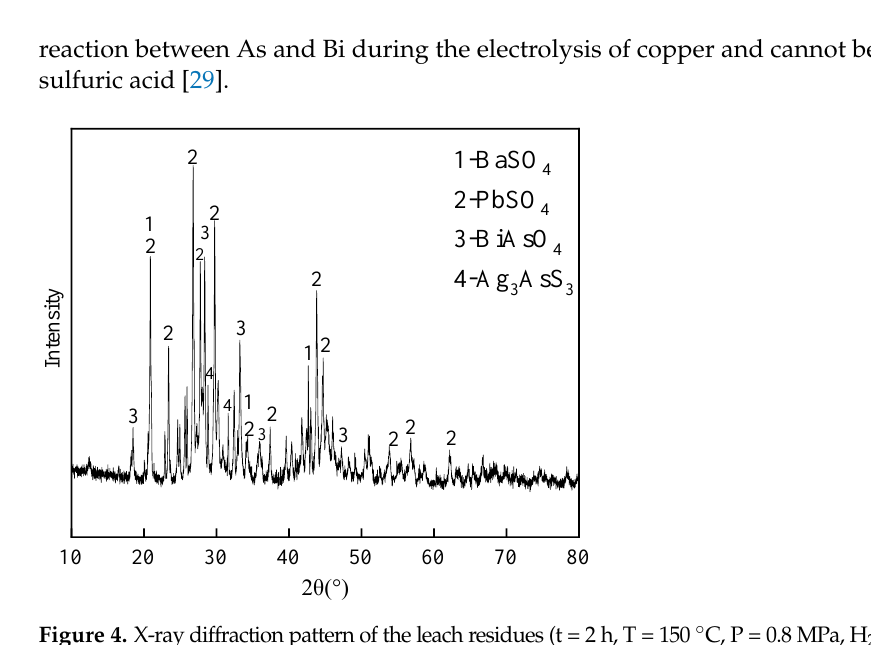
Figure 4. X-ray diffraction pattern of the leach residues (t = 2 h, T = 150 °C, P = 0.8 MPa, H 2 SO 4 = 100 g/L).